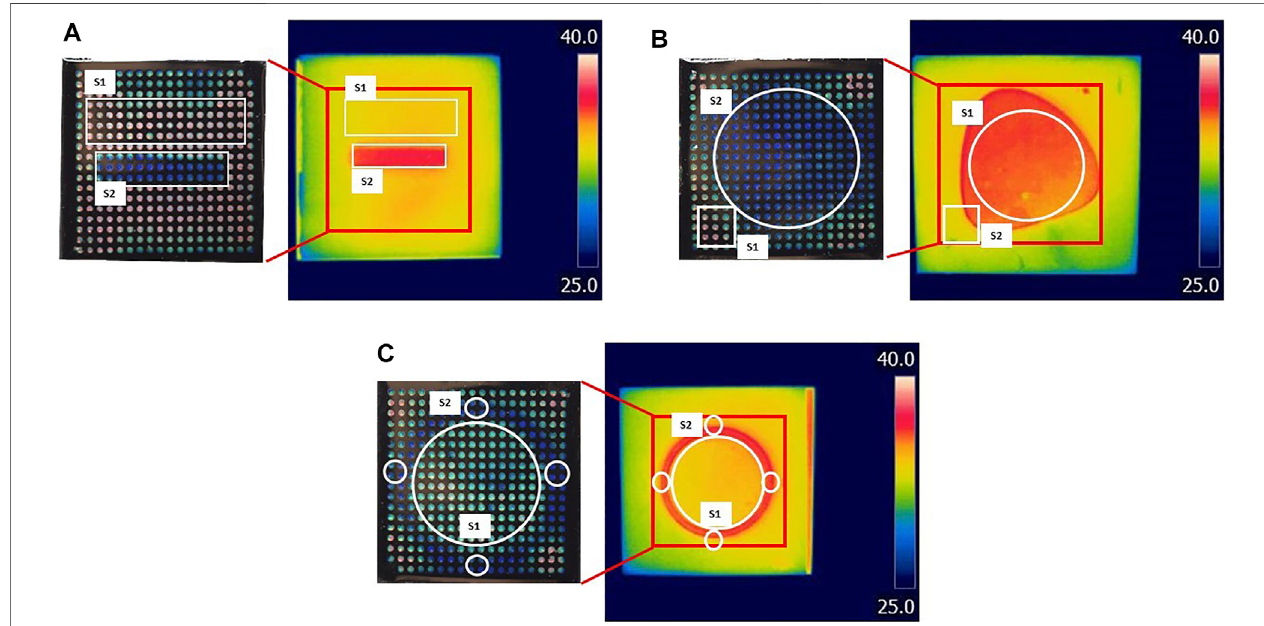
Frontiers in Bioengineering and Biotechnology |